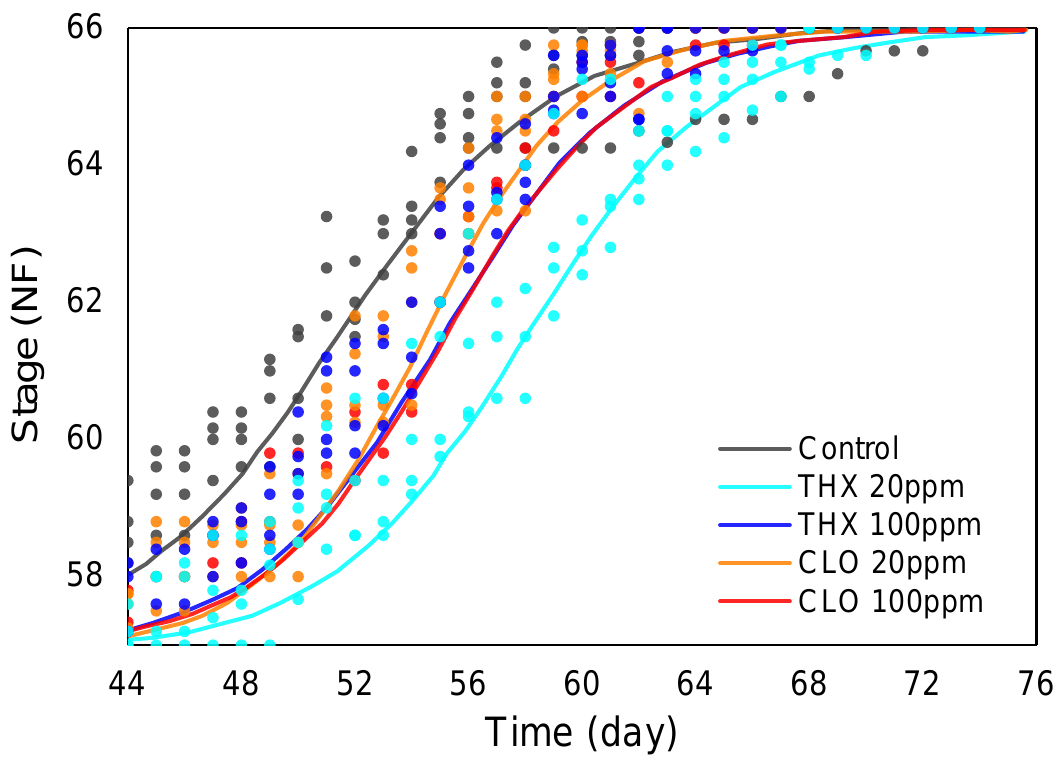
Figure 2. The progression of developmental stages of Xenopus laevis tadpoles during metamorphosis from the Nieuwkoop and Faber stages NF 57–66 in thiamethoxam (THX), clothianidin (CLO), or neonicotinoid-free control treatment groups. Each dot is the mean per one of four replicate vivaria. Solid lines were plotted after applying a two-parameter logistic growth model of developmental stage data from NF 57–66. The THX 20 ppm (low concentration) was depressed compared to that of the control group ( p = 0.004).